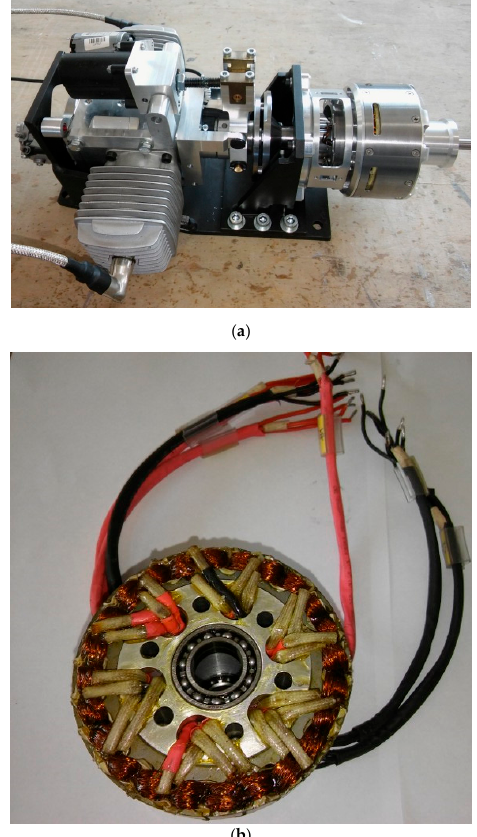
Figure 2. The prototype of a three-phase quad-channel brushless machine with a permanent magnet (QCBLDC) machine; ( a ) the hybrid drive of a small unmanned aerial vehicle; ( b ) the stator with windings.